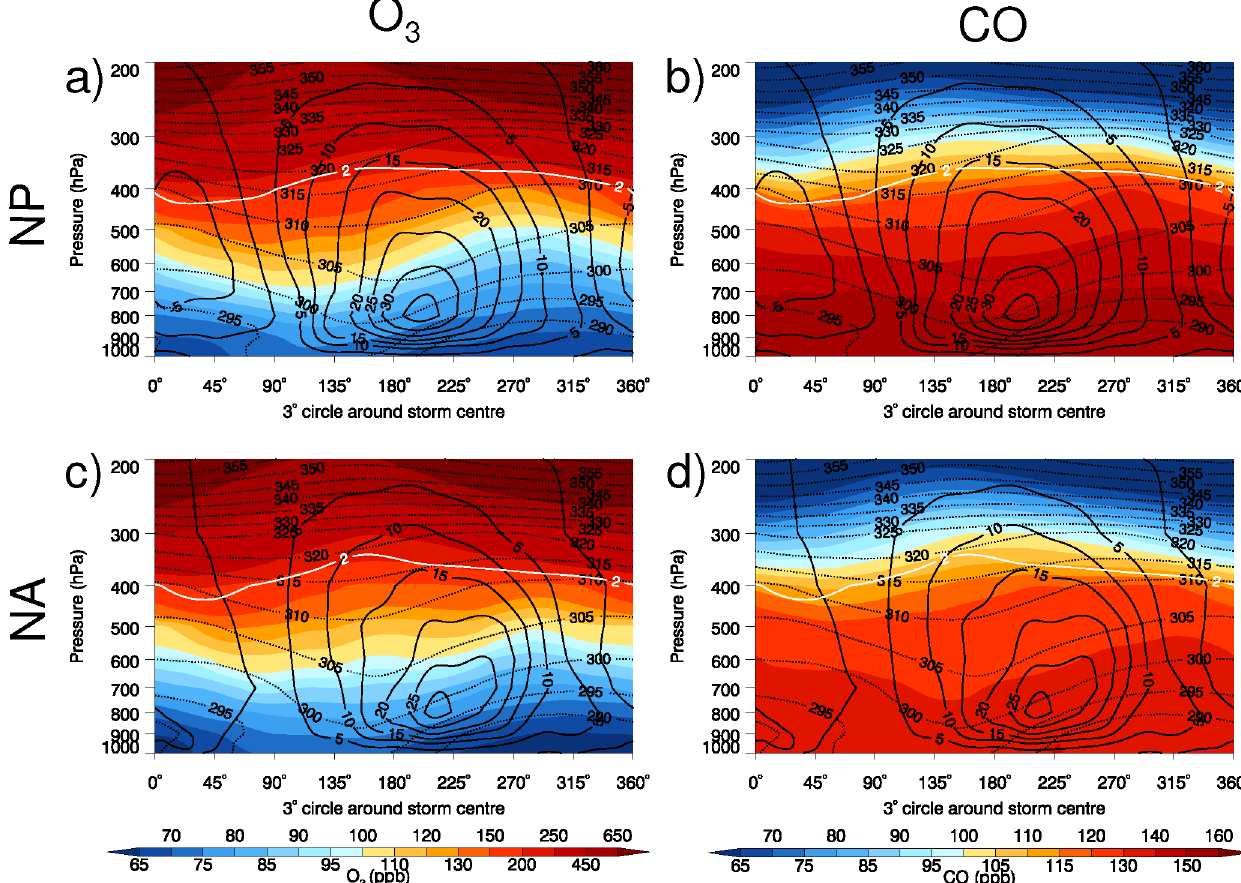
Figure 9. Vertical cylinders at 3 ◦ radius for the storm-centered composite for (a, b) NP and (c, d) NA 95th percentile MAM storm tracks during 2003–2012. (a, c) O 3 and (b, d) CO (ppb), with θ e (dotted contour lines, 5K intervals), ω (solid contour lines; 5hPah − 1 contour intervals, with positive values indicating ascent), and the isosurface of 2 PVU (solid white line) are